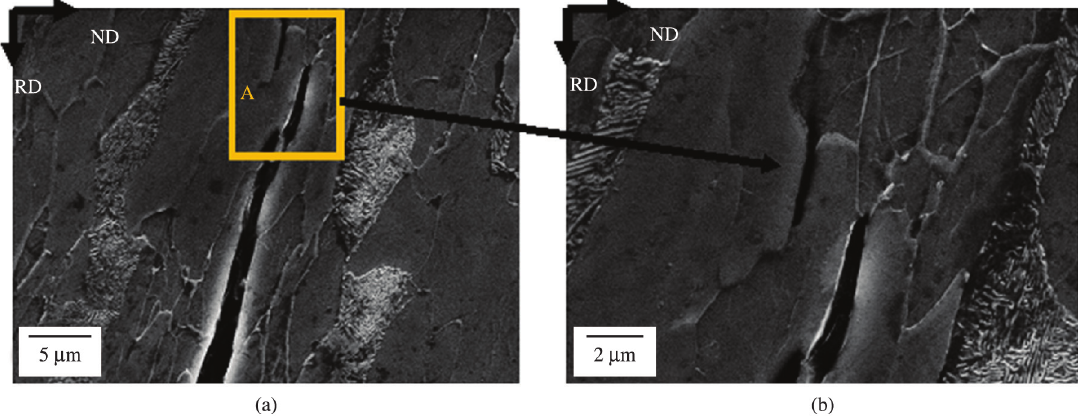
Figure 11. Microstructure from the around crack region: a) crack propagation along the ferrite; b) fissure observed in the A